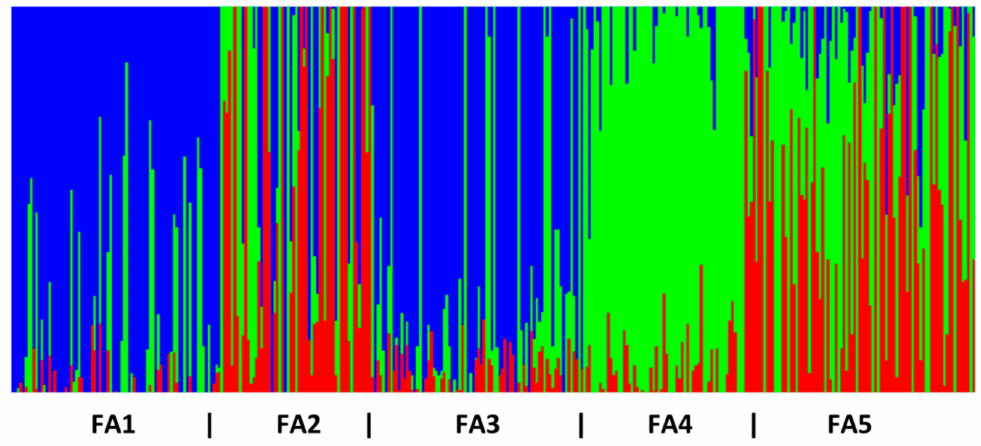
Figure 2. Structure plot depicting/justifying the genetic groups in the farmed populations.